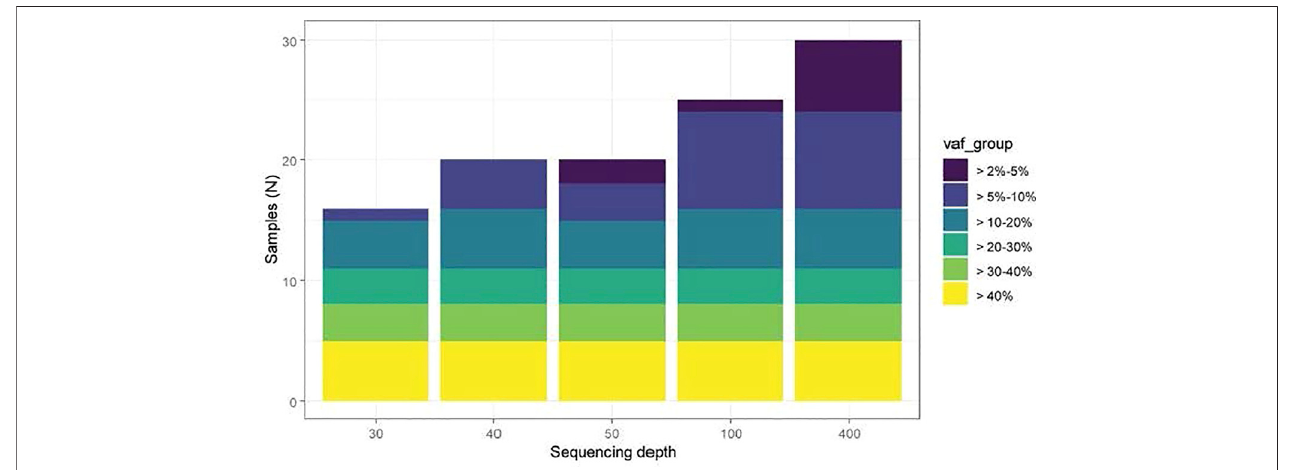
FIGURE 3 | Sensitivity of CHIP detection at different sequencing depths (Bick et al., 2020a). A set of 30 samples from a previously published CHIP cohort were computationally down sampled to30x,40x,50x,100xand 400xsequencing depth.TOPMed WGSdatawastypicallyinthe40xdepthrange acrossCHIP genes.WGS data has excellent sensitivity to detect CHIP clones with VAF > 10%, and ~50% sensitivity to detect CHIP VAF 5 – 10%, with minimal ability to detect CHIP clones < 5%.